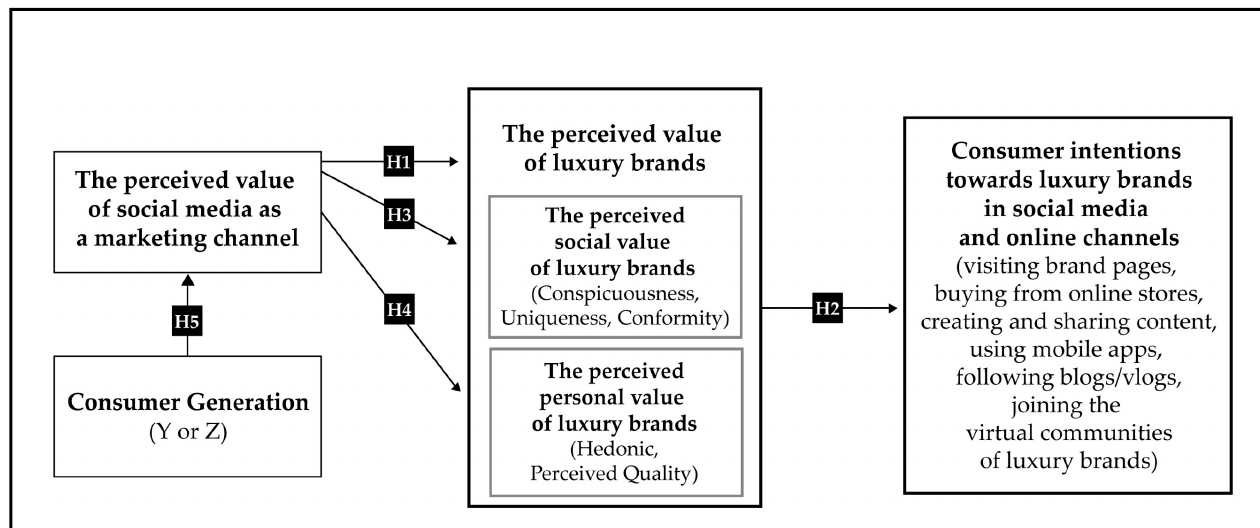
Figure 1. The proposed research model.